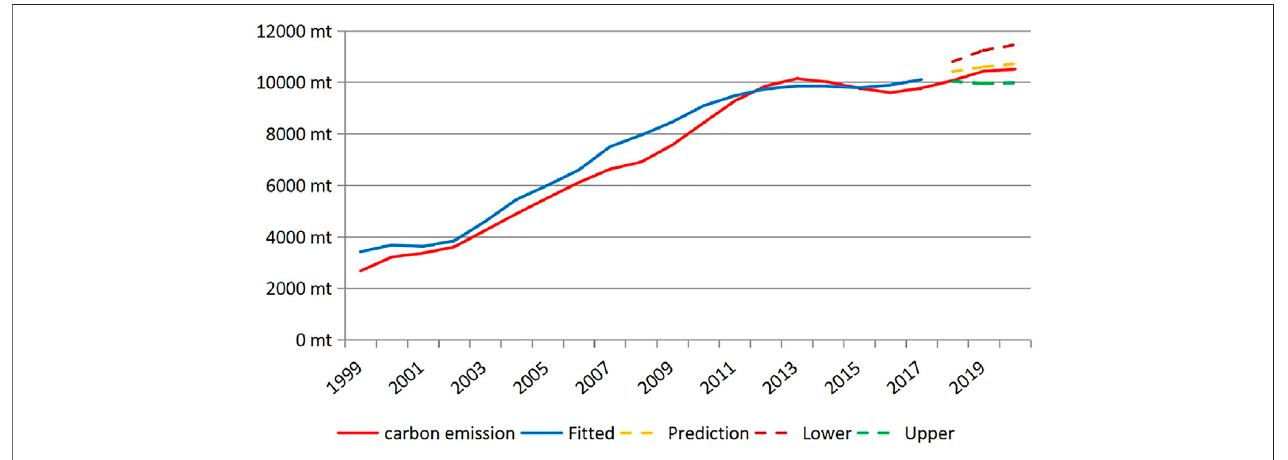
FIGURE 5 | The plots of fi tted and forecast